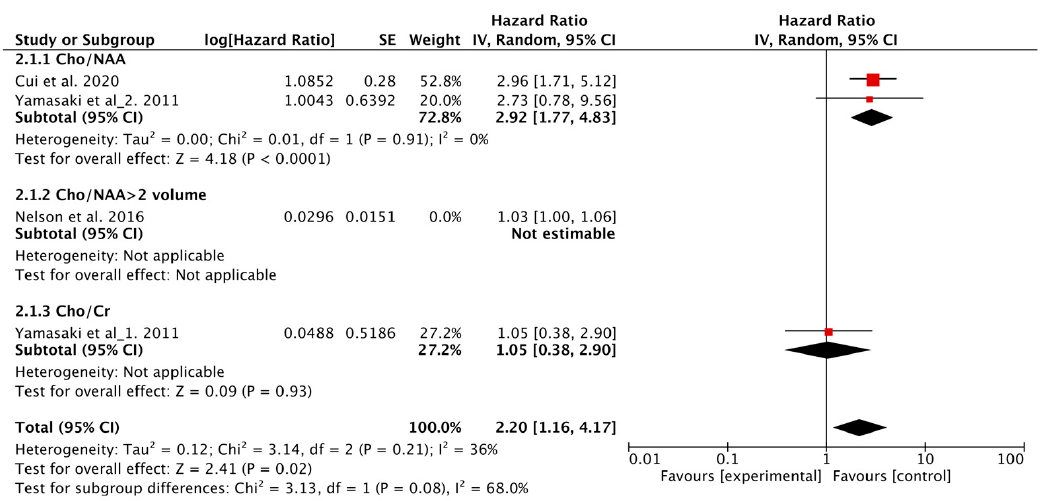
Figure 4. Forest plots of the pooled hazard ratio for PFS of choline. Figure 4 . Forest plots of the pooled hazard ratio for PFS of choline.